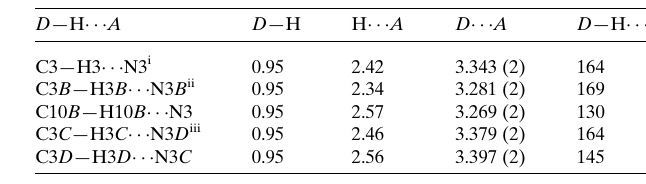
Table 1 Hydrogen-bond geometry (A˚ , (cid:3) ).